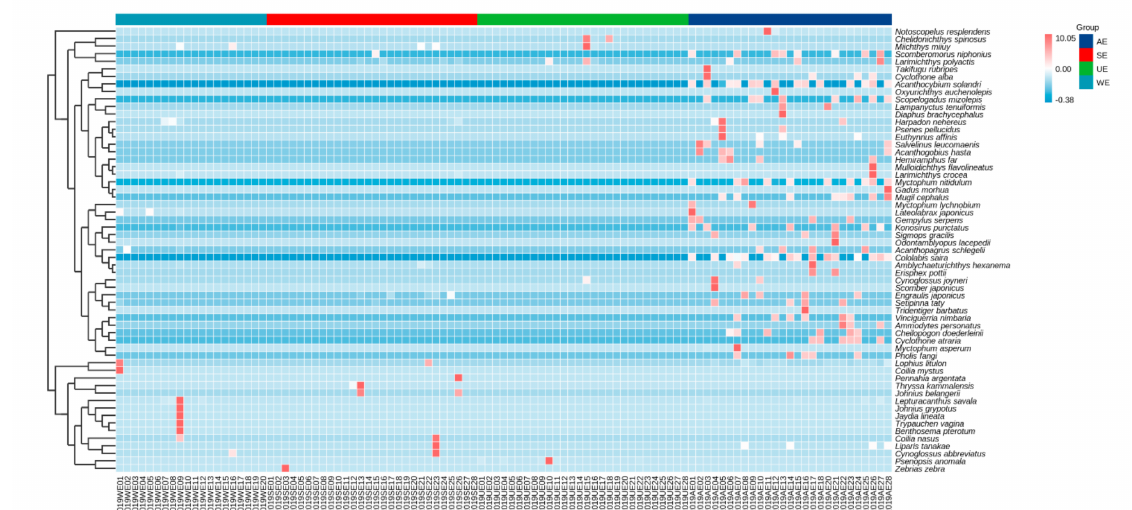
Figure 5. UPGMA shows the di ff erence of assemblage composition. The X-axes shows the sampling number; The Y-axes shows the UPGMA clustering that according to the Pearson correlation coe ffi cient matrix of the constituent data and arranged according to the clustering